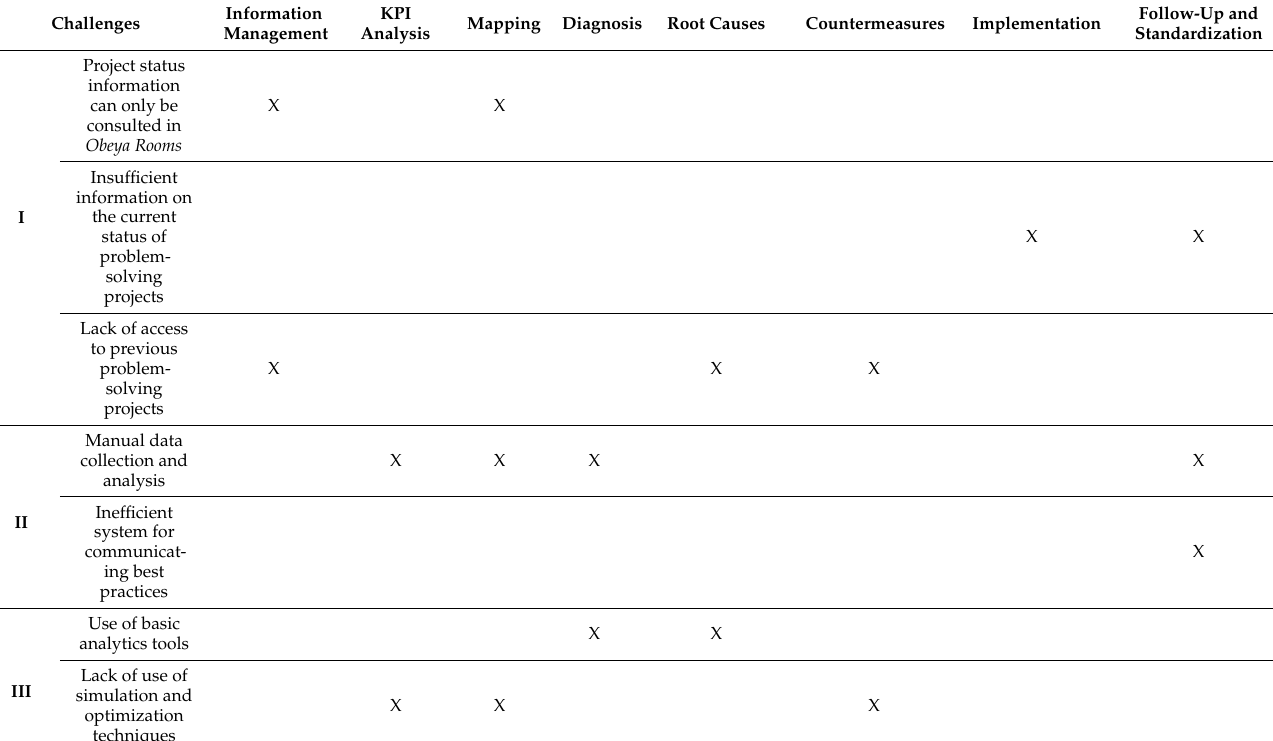
Table 2. Challenges and limitations of conventional practices for each CI